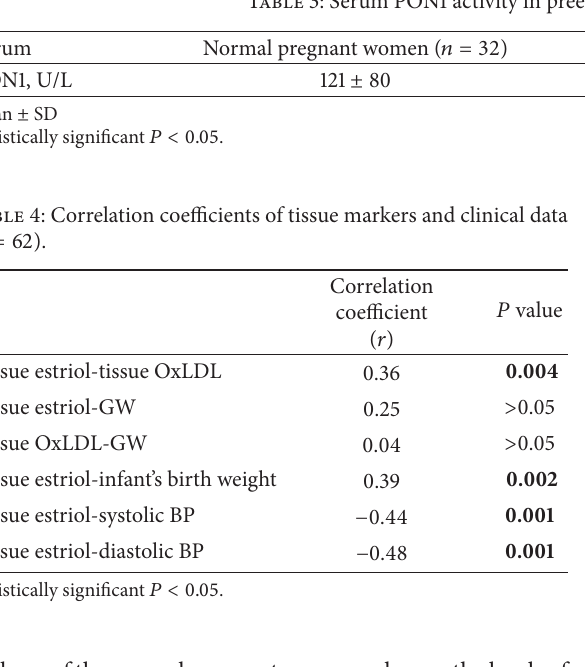
Table 3: Serum PON1 activity in preeclamptic and normal pregnant women.